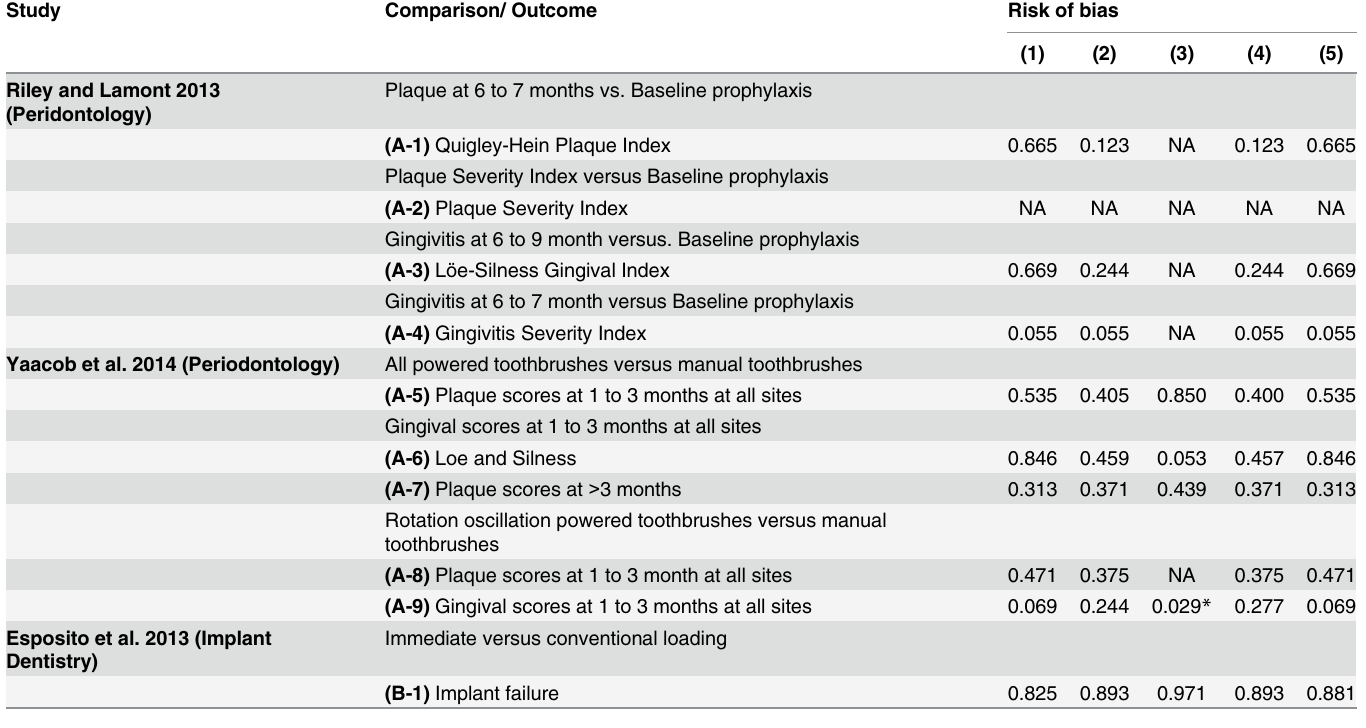
Table 2. Meta-regression assessment of the influence of different levels of risk of bias on the treatment effect estimates. (1): Sequence generation; (2): Allocation concealment; (3) Blinding of outcome assessment; (4) Sequence generation OR Allocation concealment; (5) Sequence generation OR Blind- ing of outcome assessment; (6) Allocation concealment OR Blinding of outcome assessment; (7) Sequence generation OR Allocation concealment ORBlind- ing of outcome assessment. NA = not